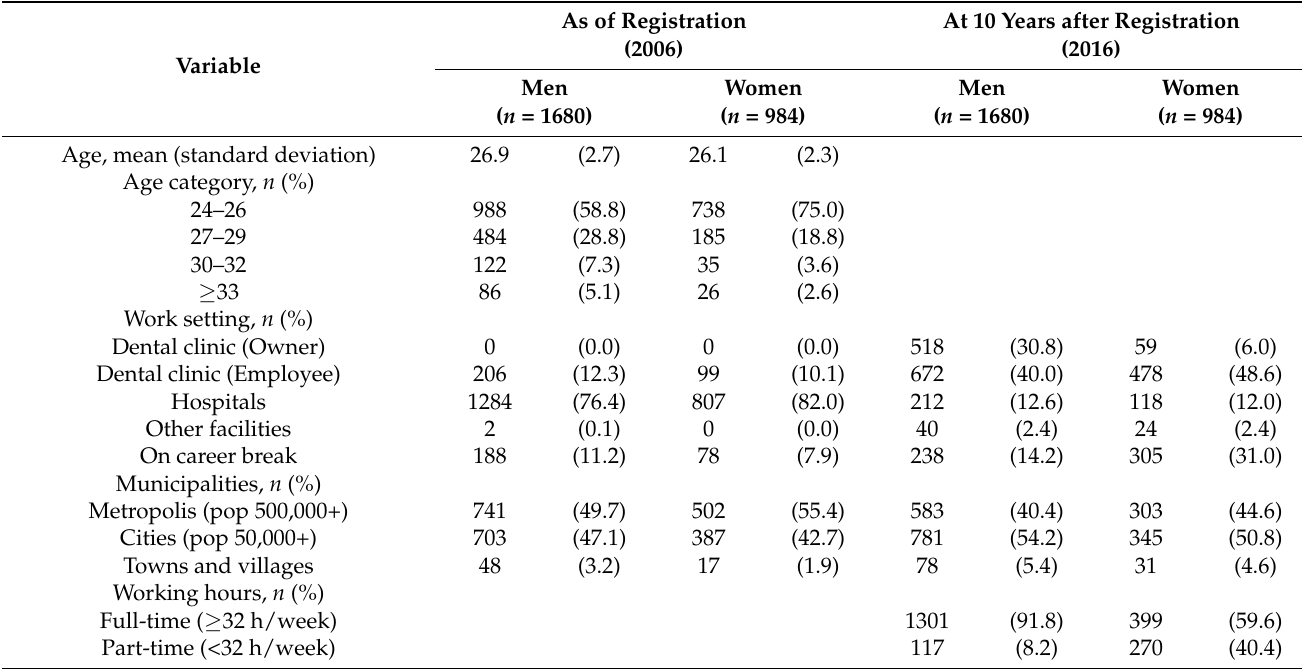
Table 1. Characteristics of the study participants (as of registration (2006) and 10 years later